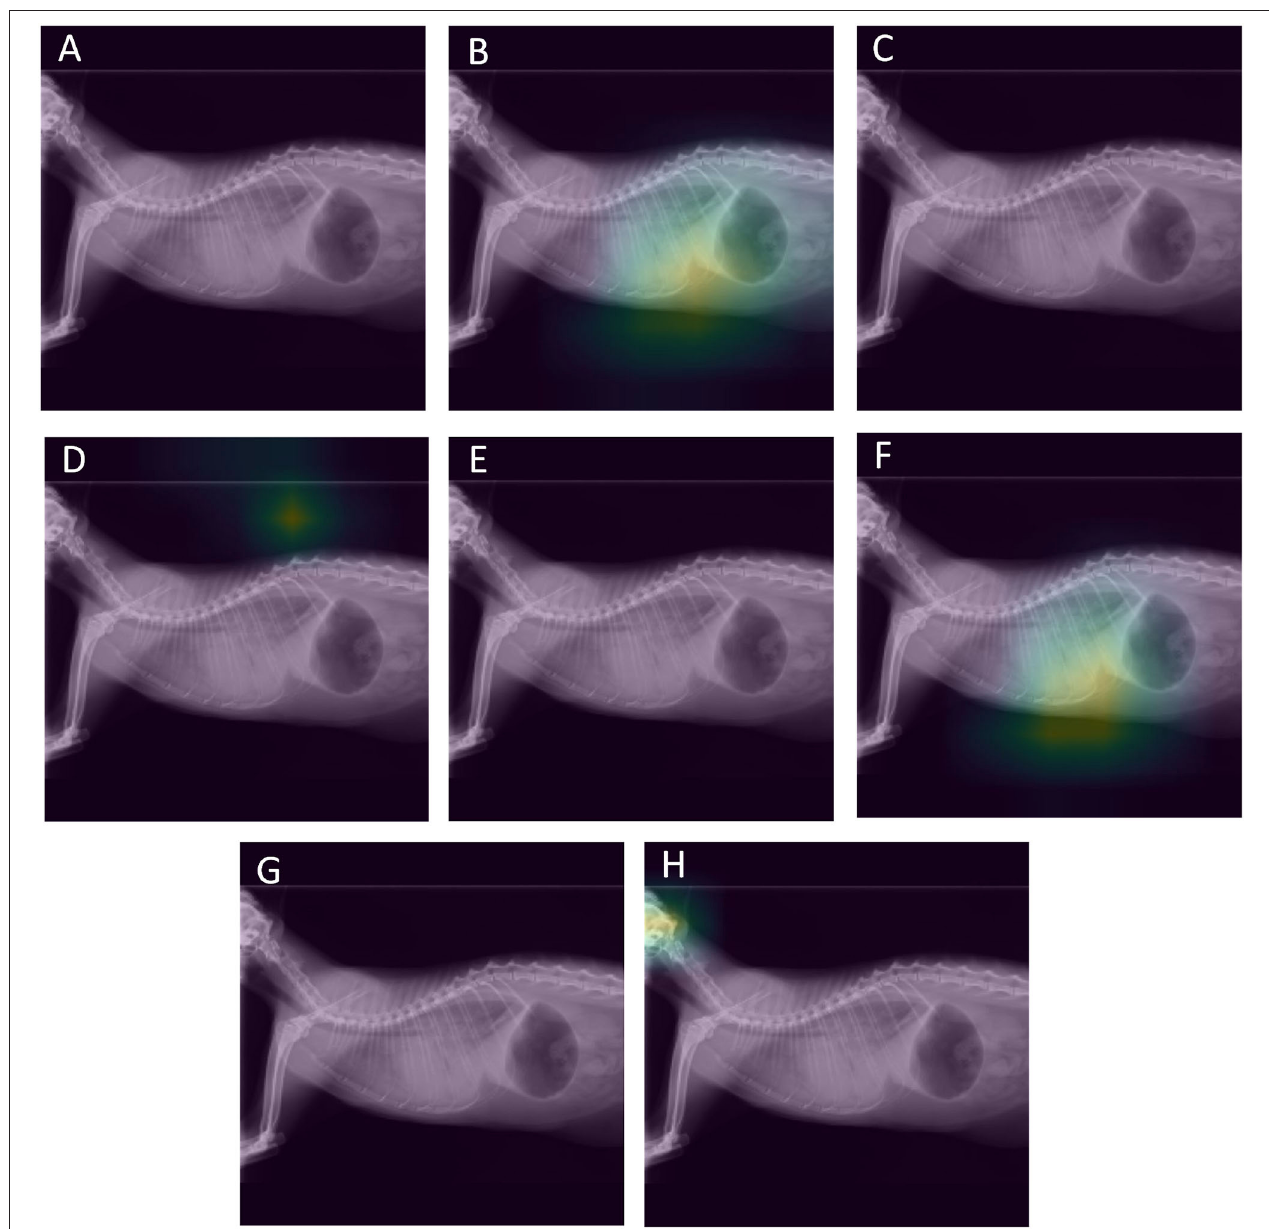
FIGURE 2 | Visual assessment of the ResNet-50 classification results of a radiograph of a cat showing cardiomegaly, an alveolar pattern both in the cranial and caudal lungs, and pleural effusion. The activations of the last layer are visualized superimposed on the radiographs. Each image corresponds to the activations for a specific radiographic finding. The alveolar pattern (B) and the pleural effusion (F) were correctly identified by the model. However, the model failed to identify the cardiomegaly (G) . (A) Original image, (B) alveolar pattern, (C) unremarkable, (D) pneumothorax, (E) mass, (F) pleural effusion (G) cardiomegaly, (H) bronchial